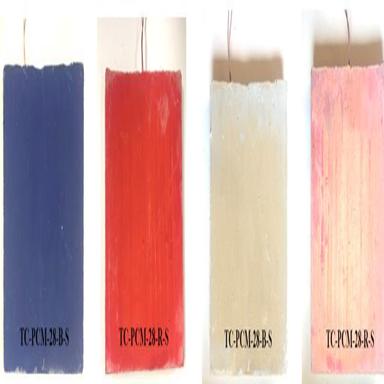
Color change of the Type 2 samples (a) Cooling cycle; (b) Heating cycle.